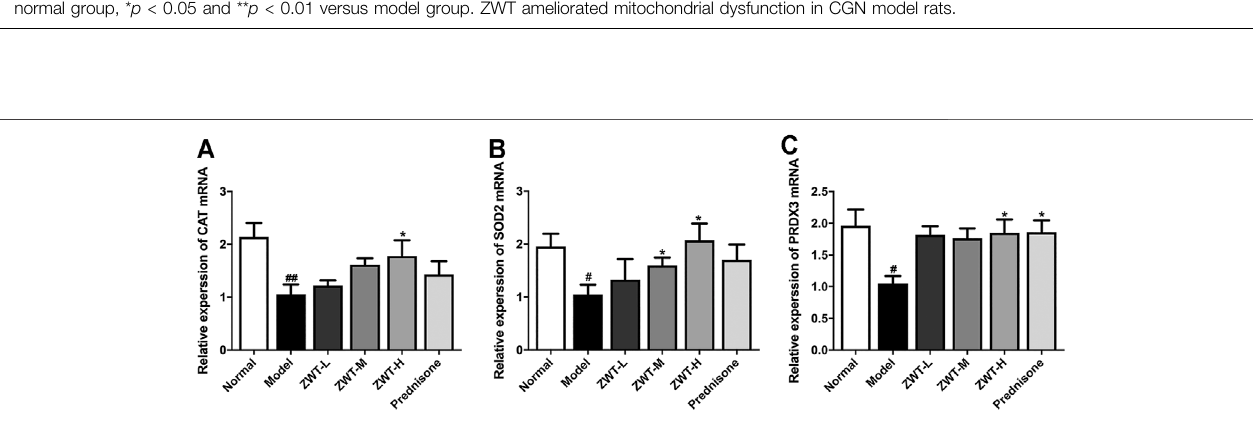
Frontiers in Pharmacology |